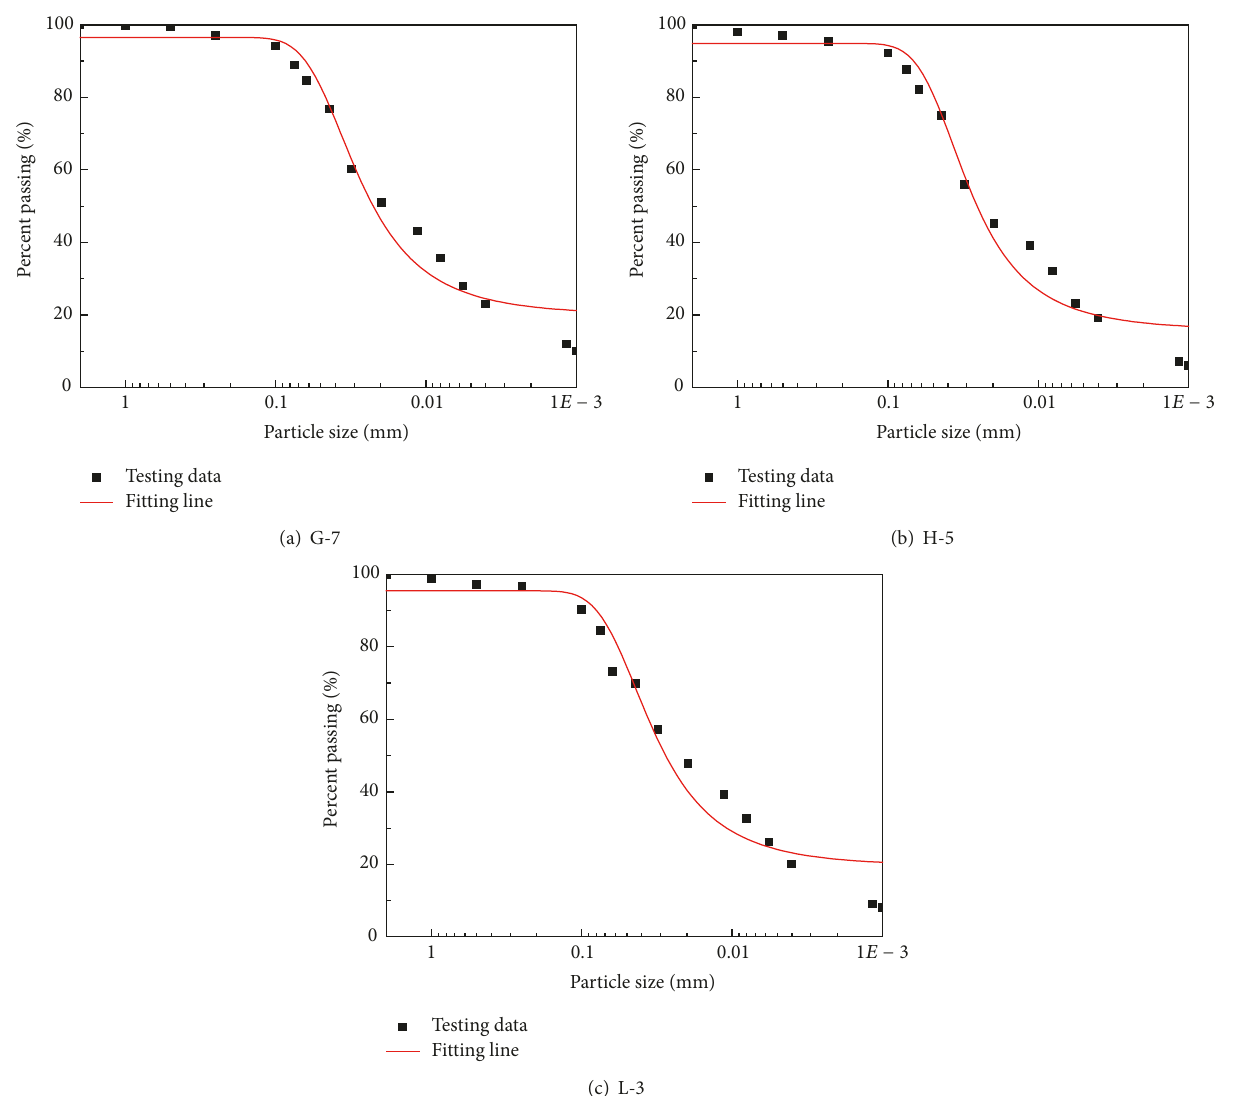
Figure 7: Performance of empirical model fitted to sieve-pipette particle size